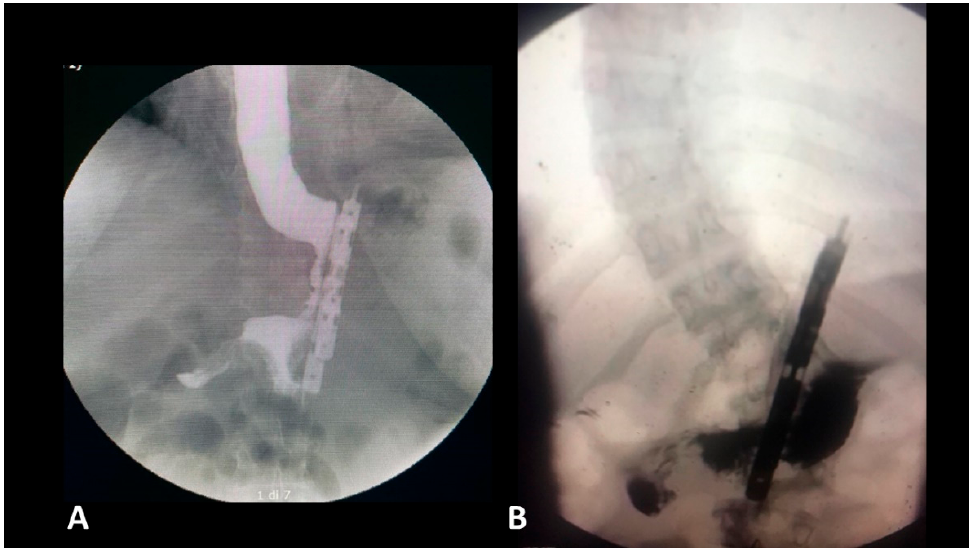
Figure 2. Postoperative gastrografin swallow ( A ) no reflux; ( B ) with reflux in the gastric remnant.